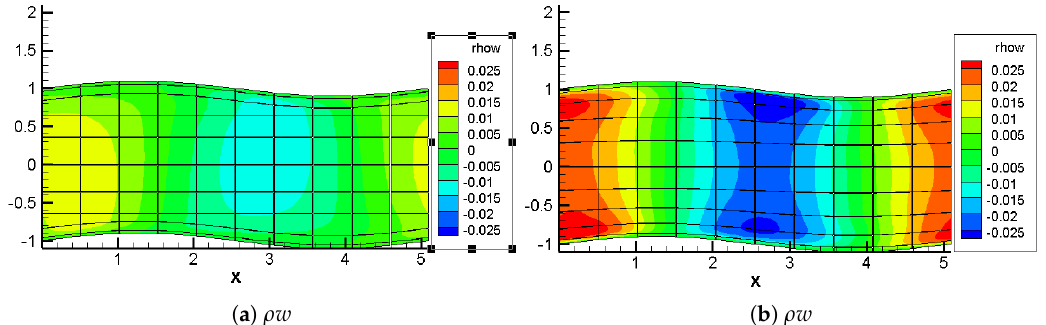
Figure 4. Wavy wall channel flow: comparison of the average vertical velocity/momentum for the laminar ( Re = 1150, a ) and turbulent ( Re = 1200, b ) cases.